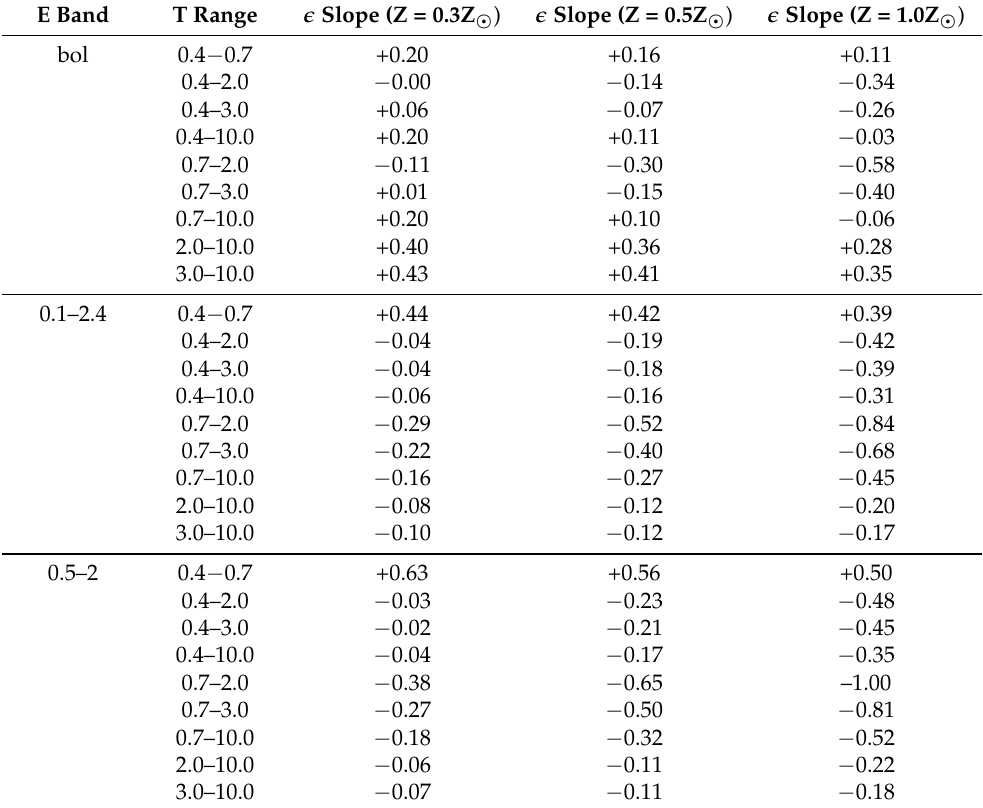
Table 1. Emissivity dependence on T x and Z (cid:12) for different temperature regimes and energy bands. E Band T